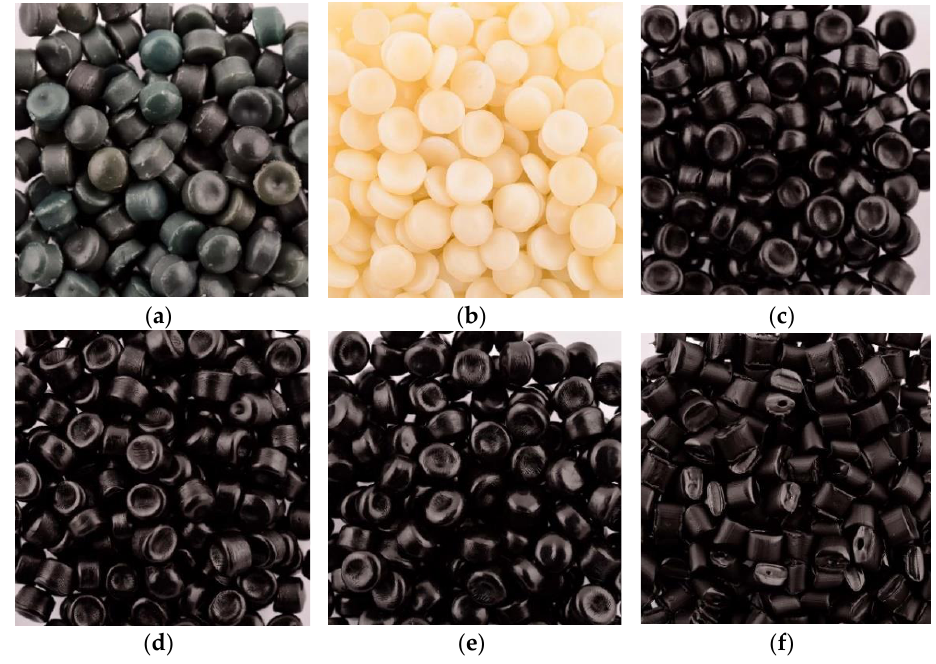
Figure 1. Images of the used pellets of rPE-A ( a ), rPE-B ( b ), PE100-RC ( c ), PE100 ( d ), PE80 ( e ), and